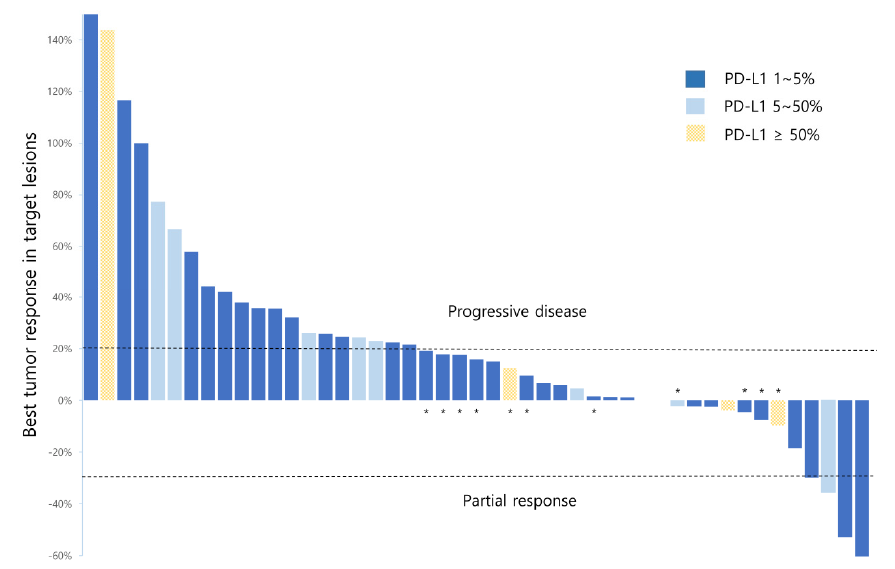
Figure 2. Tumor response and programmed death-ligand 1 (PD-L1) subgroups of evaluable patients ( n = 42). The highest percentage changes in the size of tumor target lesions from the baseline, measured using Response Evaluation Criteria in Solid Tumors (RECIST) 1.1 for the 42 evaluable patients, are shown by PD-L1 subgroups. * Eleven patients with progressive disease based on RECIST 1.1 due to the unequivocal progression of non-target lesions despite < 20% growth in target lesions.